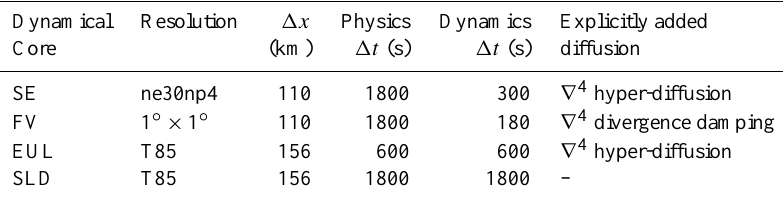
Table 1. Horizontal grid resolutions with approximate grid spacings (cid:49)x near the Equator, physics and dynamics time steps (cid:49)t , and explicitly added diffusion mechanisms for all four dynamical